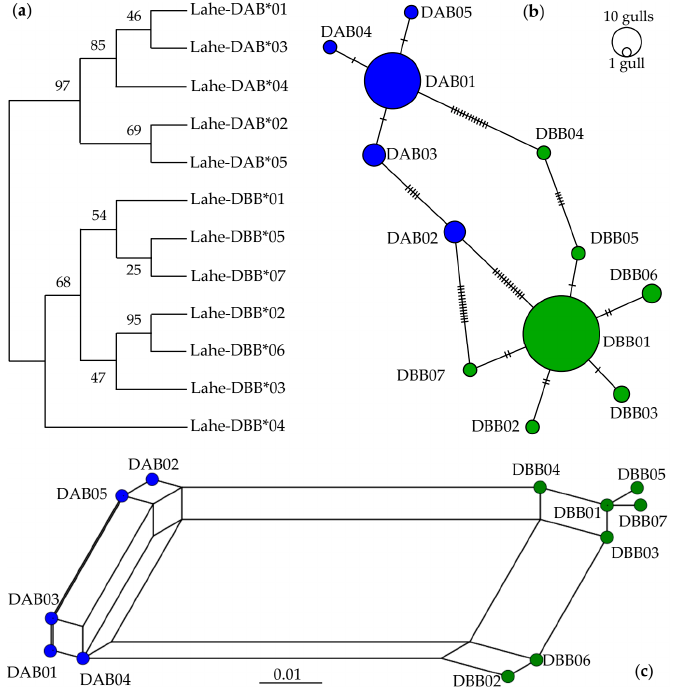
Figure 1. Relationships among MHCIIB alleles suggest at least two loci in Heermann’s Gull. Five and seven putative true alleles were grouped in the DAB (in blue) and DBB (green) clusters, respectively, by three approaches: ( a ) maximum likelihood tree showing the percentage of trees in which associated alleles were clustered together after 1000 bootstrap pseudoreplicates. ( b ) Minimum spanning network connecting each allele with circle sizes proportional to the number of individuals in which they were found; parallel lines show differences in base pairs. ( c ) Neighbor-net phylogenetic network exhibiting relationships between alleles with lines representing reticular (mutation) events and circles depicting each allele.